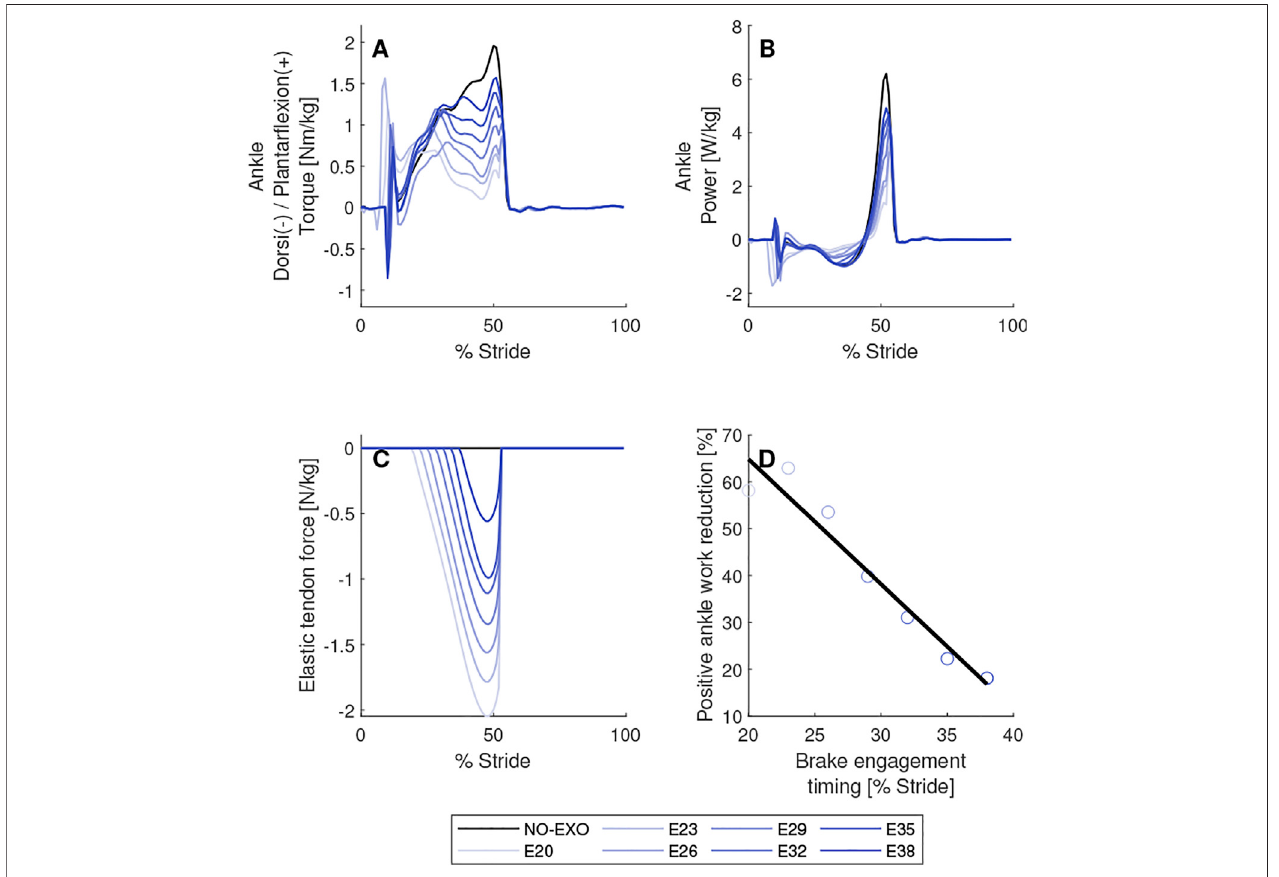
FIGURE 7 | Brake engagement timing parameter sweep. Biological torques (A) and powers (B) are shown for the right leg on which AN-EXTRA-Push is worn. In (C) , force in the elastic tendon is shown. In (D) , linear regression between brake engagement timing and positive ankle work reduction is shown. Elastic tendon stiffness value was set to 4.85 N/m/kg and brake disengagement timing was set to 53% of stride. Conditions are abbreviated and color coded as follows: without exoskeleton (NO-EXO)(black)andactiveexoskeletonassistance withbrakeengagementtimingsof{20,23,26,29,32,35,38}%ofstride(E20,E23,E26,E29,E32,E35,E38) (blue; from light to dark in the same